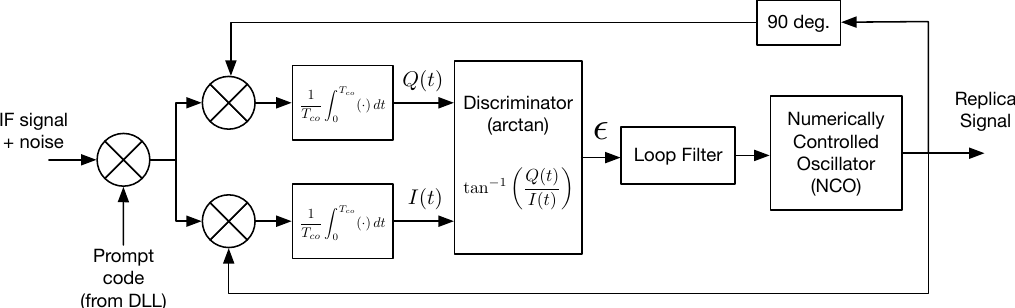
Figure 1. Phase lock loop block